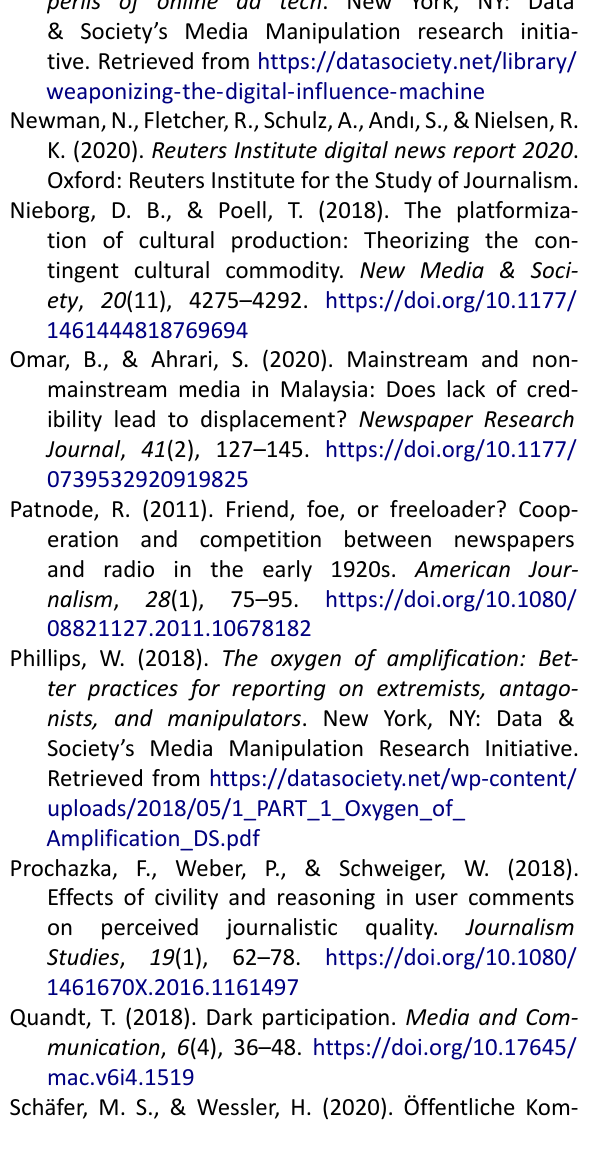
Figur des Parasiten [Parasitic structure formation: Insights from system and network theory into the figure of the parasite]. In B. P. Priddat & M.